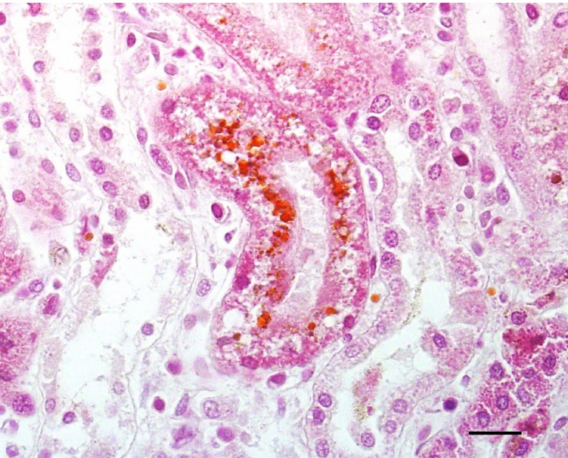
Figure 7. Kidney of a lamb with yellow lamb disease showing hemoglobinuria-associated acute tubular injury. The intracytoplasmic droplets are stained orange/brown with an Okajima stain for hemoglobin. Bar = 40 µ m.